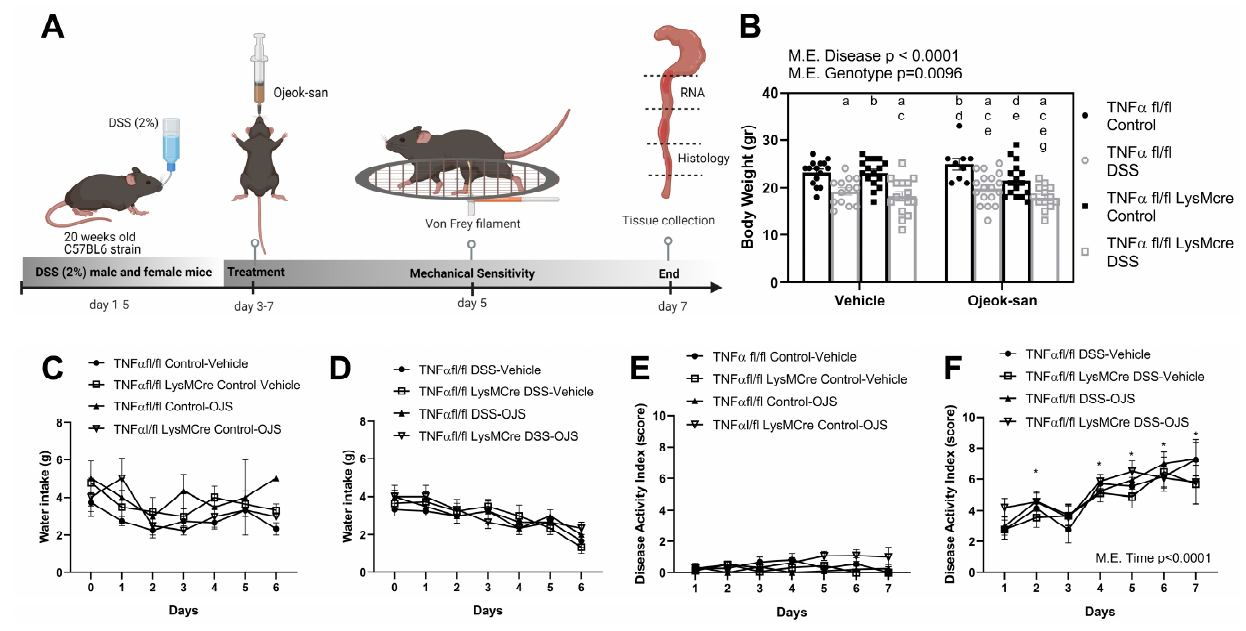
Figure 1. Macrophage deletion of TNF α and Ojeok-san administration does not impact disease progression in a chemical model of acute colitis. ( A ) Graphical depiction of the experimental design, ( B ) body weight, ( C ) water intake in control animals, ( D ) water intake in DSS-treated mice, ( E ) dis- ease activity index in control animals, and ( F ) disease activity index in DSS-treated mice. Values are represented as mean ± SEM; n = 10–18 mice per group. Three-way ANOVA for B. Le tt ers indicate statistical signi fi cance ( p < 0.05) from a TNF α fl / fl Control-Vehicle, b TNF α fl / fl DSS-Vehicle, c TNF α fl / fl LysMcre Control-Vehicle, d TNF α fl / fl LysMcre DSS-Vehicle, e TNF α fl / fl Control-OJS, f TNF α fl / fl DSS-OJS, g TNF α fl / fl LysMcre Control-OJS. Mixed-e ff ects model followed by an uncorrected Fisher’s LSD post hoc test for C–F. * Indicates statistical di ff erence from the TNF α fl / fl DSS-Vehicle group on day 1. Figure 2A,B are representative colon tissue H&E images from control and colitis mice, respectively. There was a main e ff ect of the disease (colitis), in terms of decreasing colon length, increasing colon weight, and exacerbating in fl ammation in mice with colitis (Figure 2C,E, p < 0.0001). TNF α fl / fl -LysMcre Control-OJS mice displayed a shorter colon length relative to TNF α fl / fl Control-OJS mice ( p = 0.0382). An interaction between geno- type and disease was found to decrease the in fl ammatory score in TNF α fl / fl -LysMcre Control-Vehicle mice when compared to TNF α fl / fl Control-Vehicle mice ( p = 0.004).